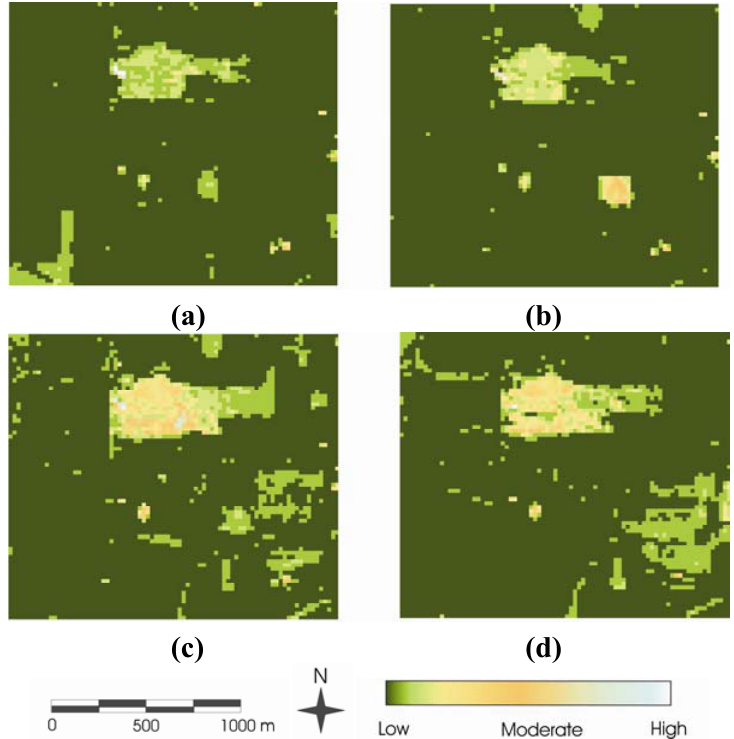
Figure 6. Characterization of surface vegetation anomaly patterns: (a) 30 August